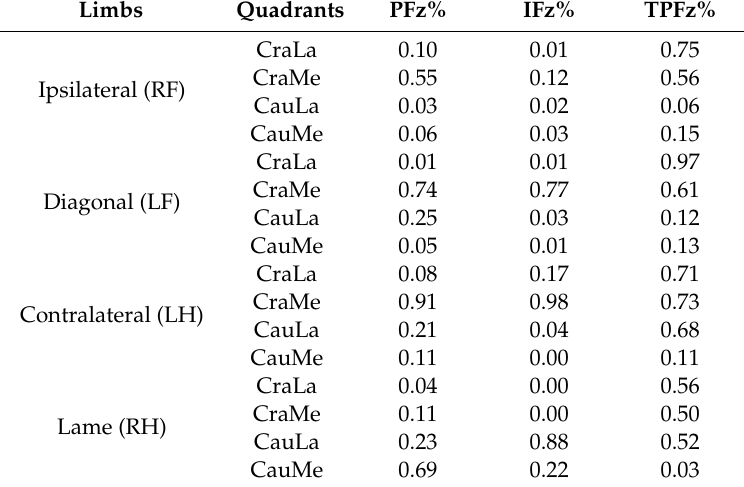
Table 7. The p values for PFz%, IFz%, and TPFz% comparing the quadrants CraLa, CraMe, CauLa, and CauMe of the IPSI (RF), DIA (LF), CONT (LH), L (RH) limbs between G Sou and G Cox . Limbs Quadrants PFz% IFz% TPFz% CraLa 0.10 0.01 0.75 CraMe 0.55 0.12 0.56 Ipsilateral (RF) CauLa 0.03 0.02 0.06 CauMe 0.06 0.03 0.15 CraLa Diagonal (LF)